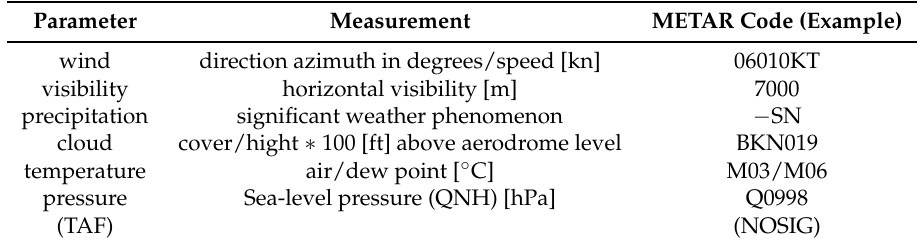
Table 2. Main components of Meteorological Aviation Routine Weather Report (METAR)